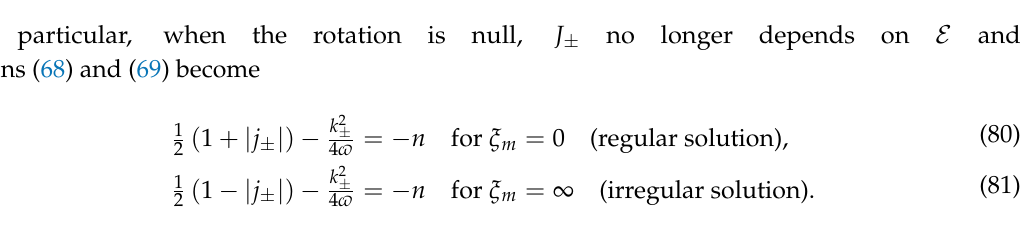
Figure 4. Sketch of the energy levels E ω = 1 and, In ( b ), a = 0.1, α = 0.2 and ω =